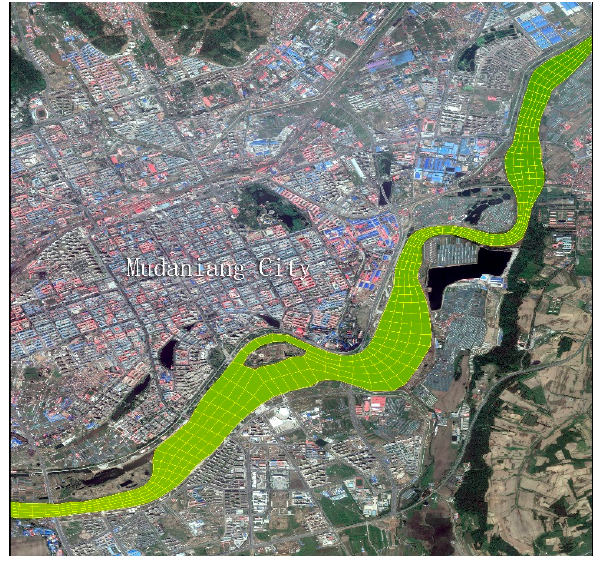
Figure 2. Grid division for urban section of the Mudan River trunk stream (part).